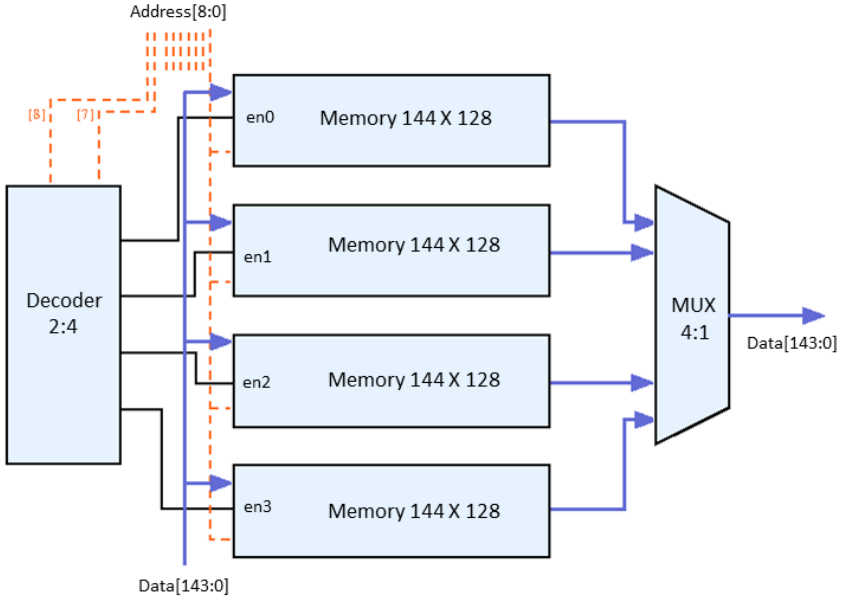
Figure 6. Applied memory split technique to the